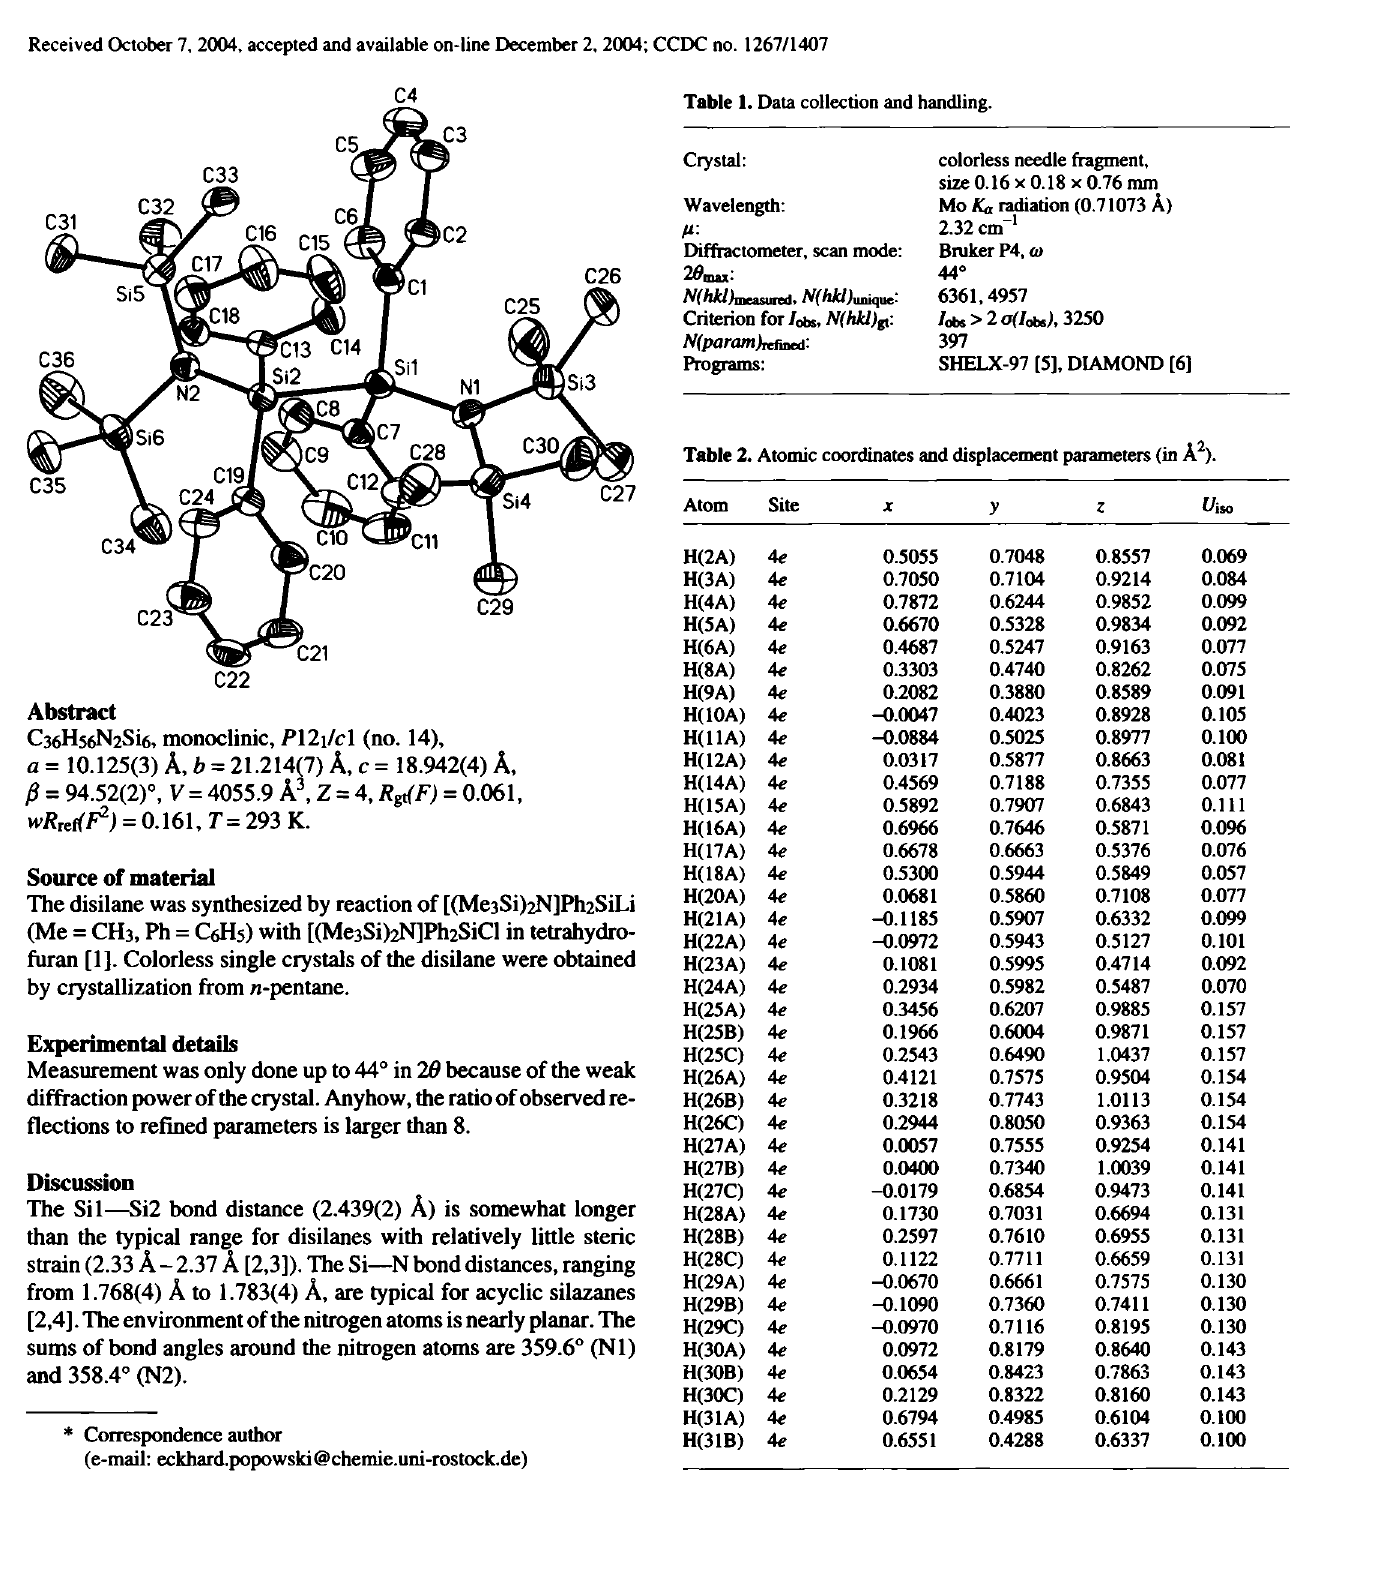
Table 2. Atomic coordinates and displacement parameters (in A 2